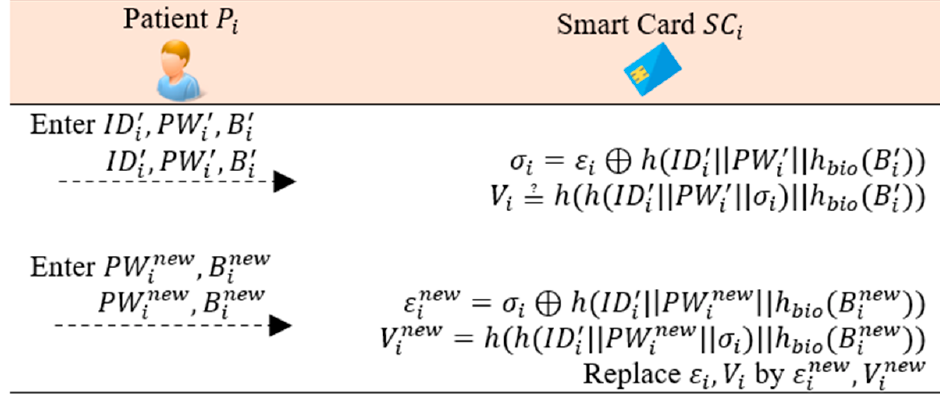
Figure 4. Password and biometrics update procedure of the proposed